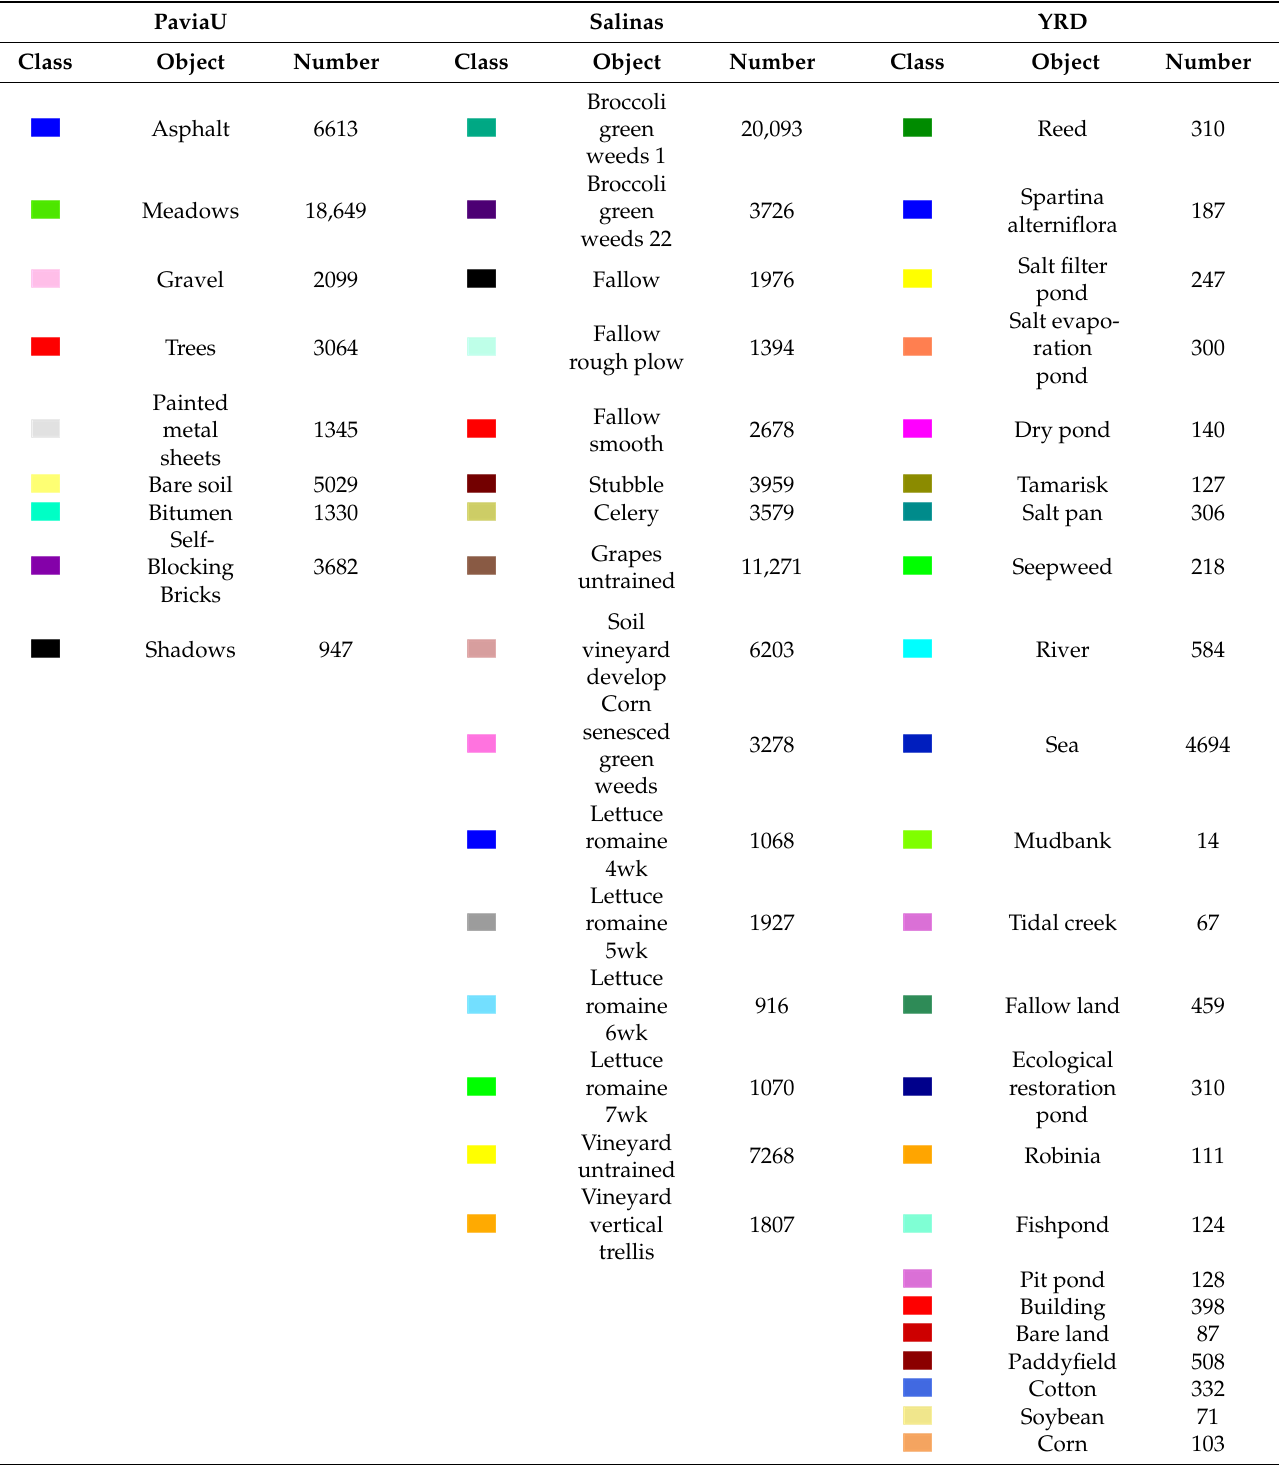
Table 2. Classes of ground objects with number of labeled samples for three data